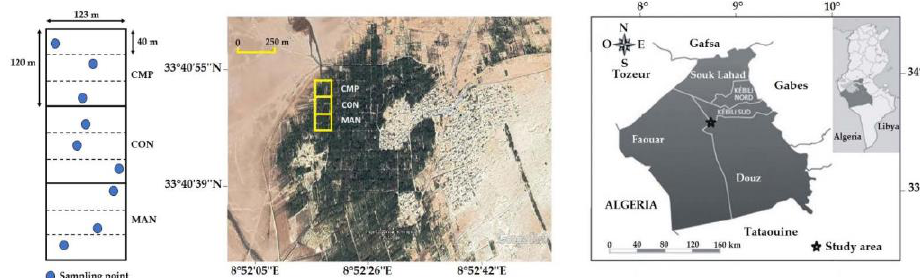
Figure 1. Geographic location maps of the study region and the experimental plots plan. CON: unamended control soil; CMP: soil with compost; MAN: soil with manure.